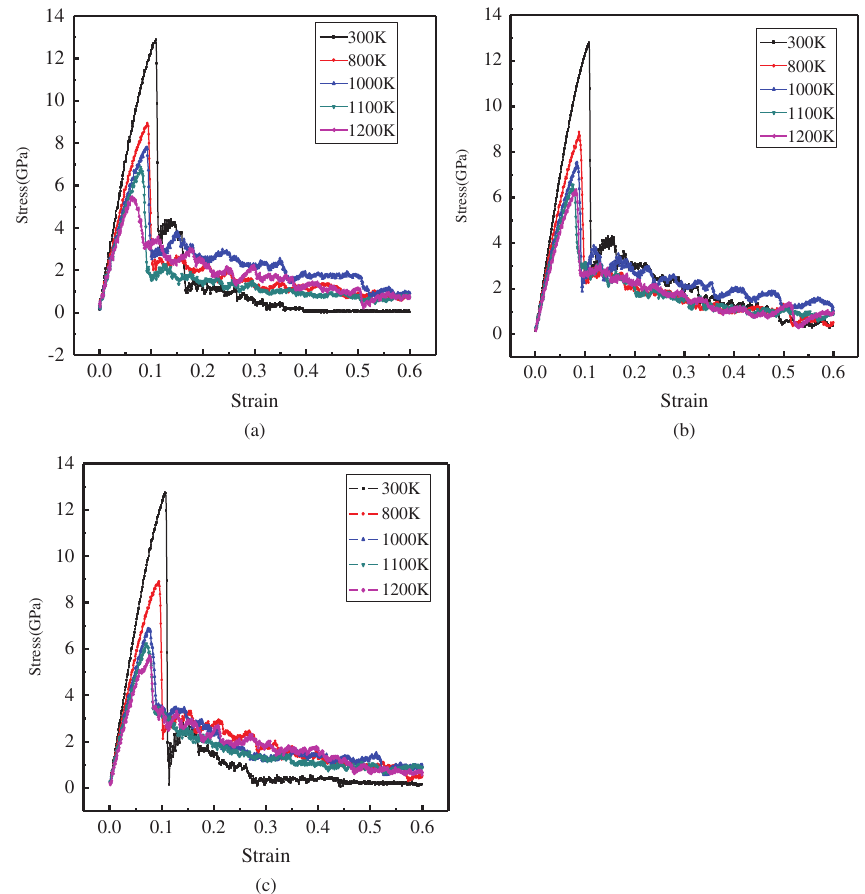
Figure 4: Stress – strain curves at different temperatures and vacancy